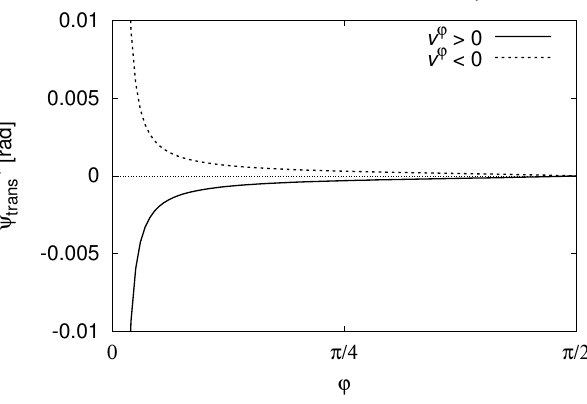
Figure 6. φ dependence of Equation